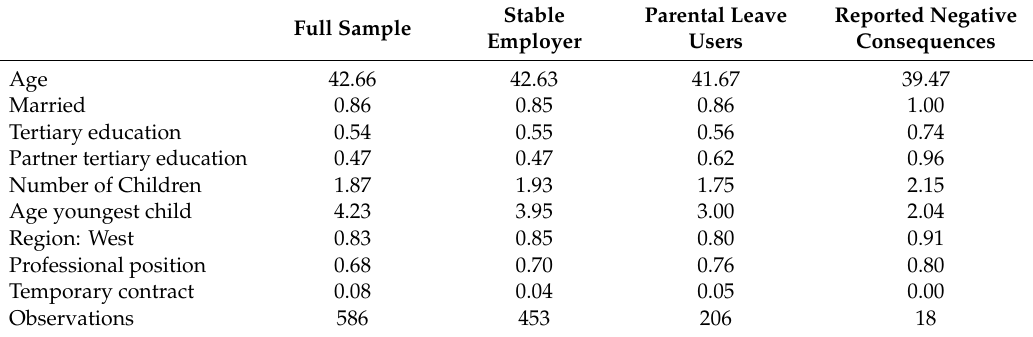
Table A2. Summary statistics for men (full sample), men with a stable employer, men who took parental leave, and men who reported negative consequences. Men who were unemployed or not employed at the time of the interview were excluded.